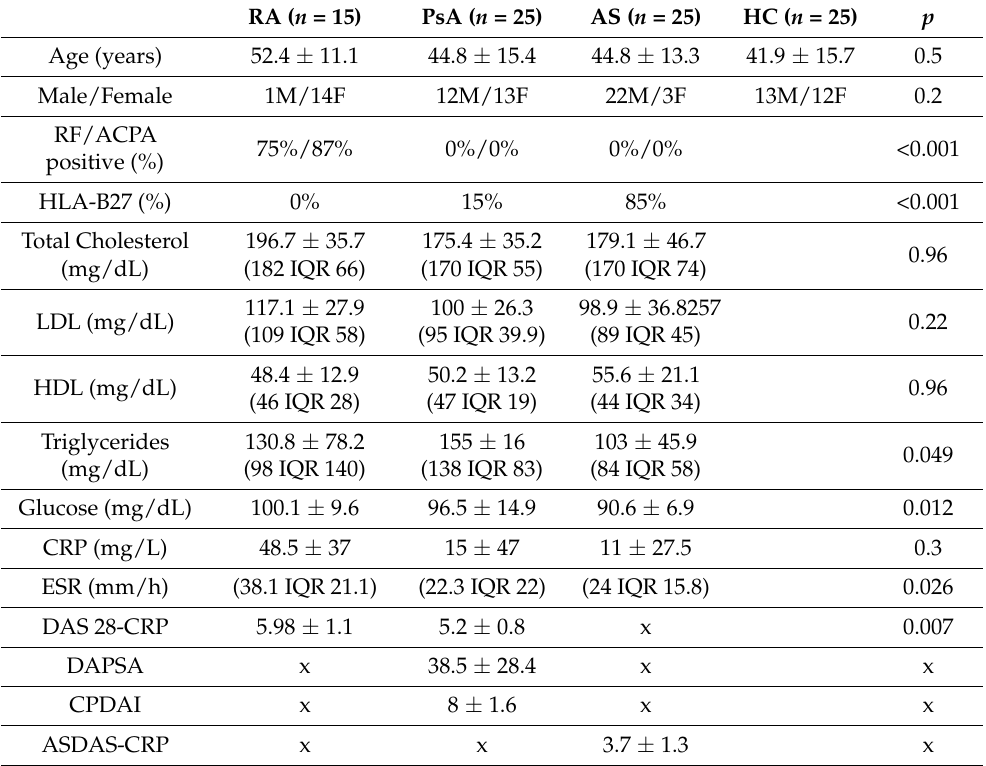
Table 1. Demographic and clinical characteristics of patients.